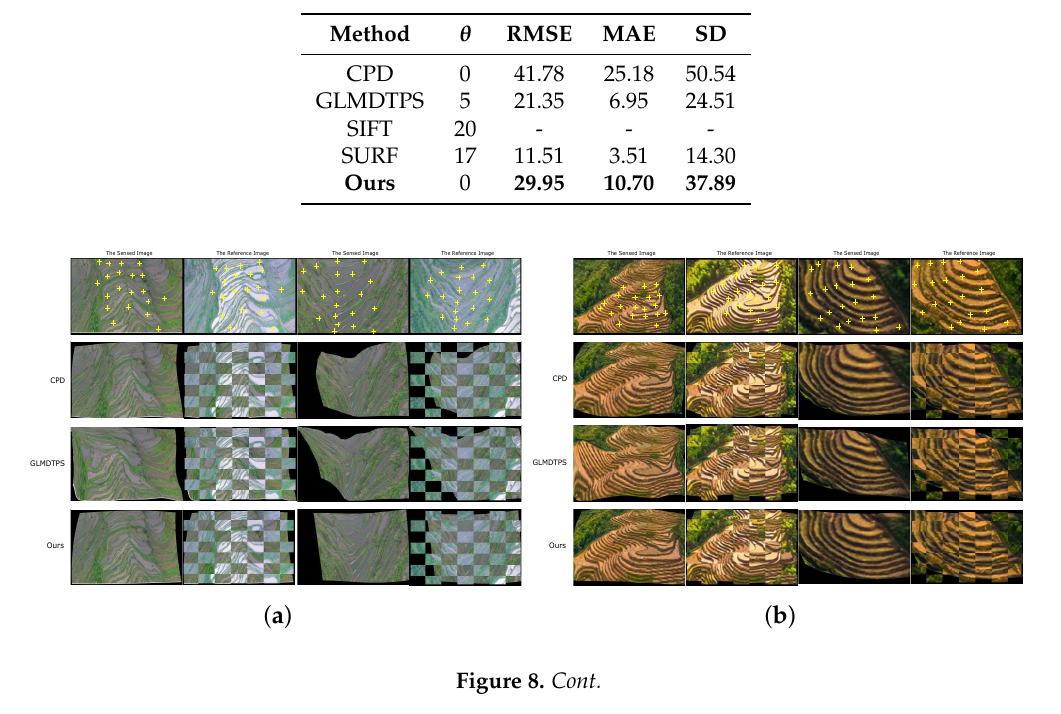
Table 2. Experimental results on series (ii). Quantitative comparisons on image registration measured using the mean RMSE (root of mean square error), MAE (mean absolute error) and SD (standard deviation) are carried out. 0 ≤ θ ≤ 20 denotes the number of the failed registrations (can not manually identify landmarks). Bold fonts indicate the best results, and all units are in pixels. CPD (coherent point drift) denotes the method [29], GLMDTPS (global and local mixture distance with thin plate spline transformation) denotes the method [30], SIFT (scale invariant feature transform) denotes the method [38] and SURF (speeded-up robust features) denotes the method [39].